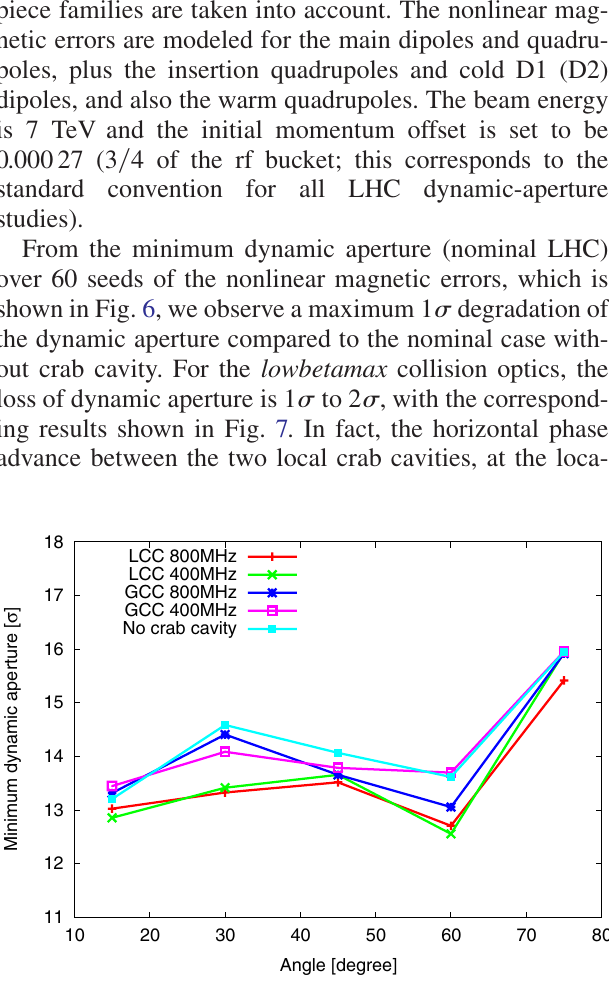
FIG. 6. (Color) Minimum dynamic aperture over 60 error seeds for nominal LHC optics with or without crab cavity; the maxi- mum decrease of 1 (cid:3) due to crab cavity is acceptable. The dynamic-aperture tracking is performed for 100 000 turns.